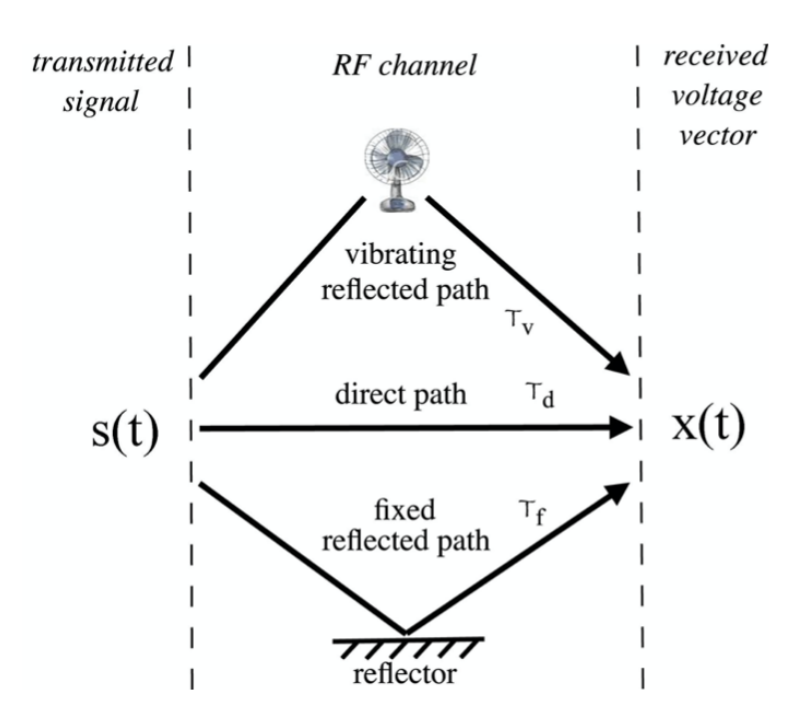
Figure 3. polarization mode dispersion (PMD) caused by multi paths